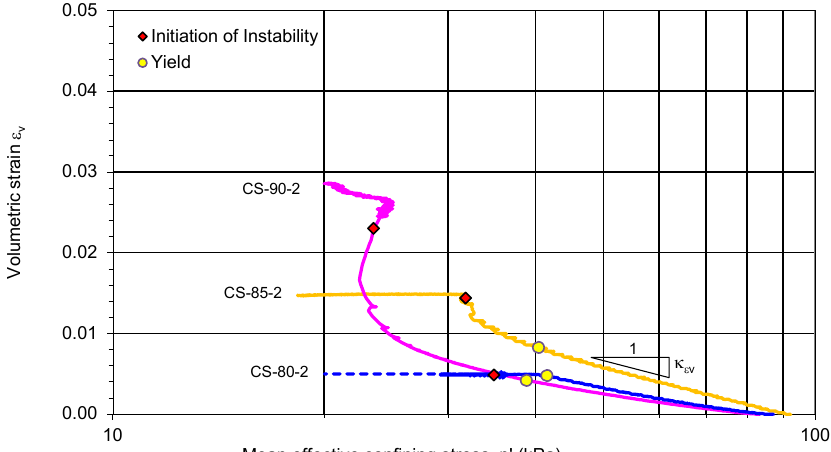
Figure 11. Yield states of the CS tests.